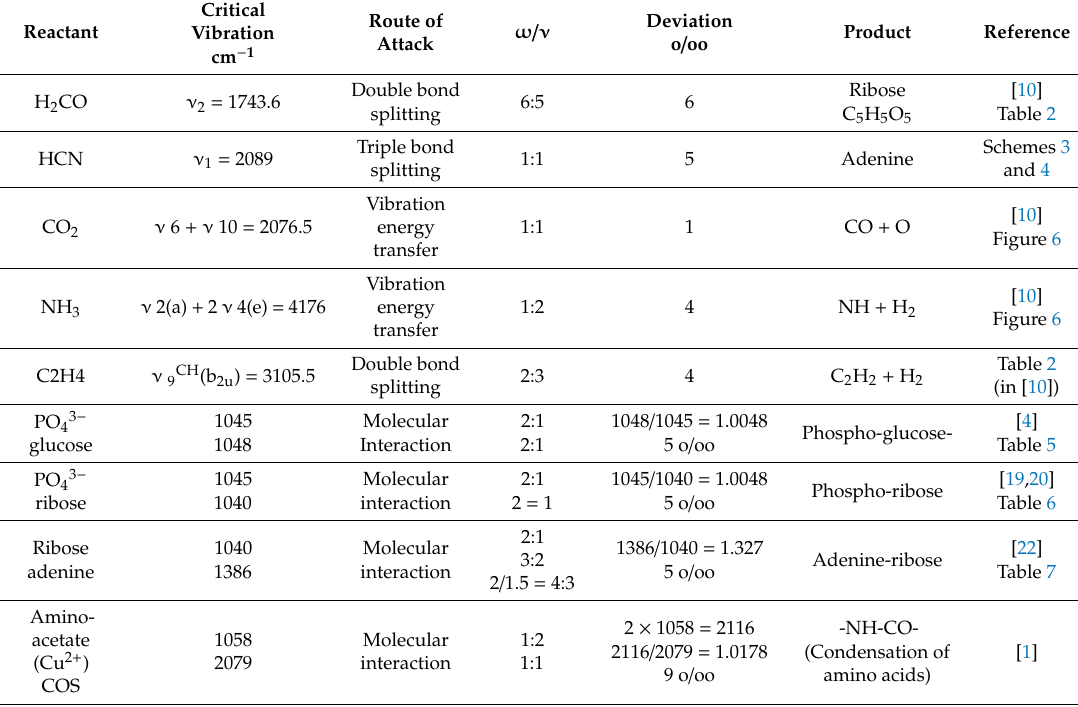
Table 8. The influence of the catalyst COS ( ω = 2079 cm − 1 ) on the reactions mentioned here, indicating the type of